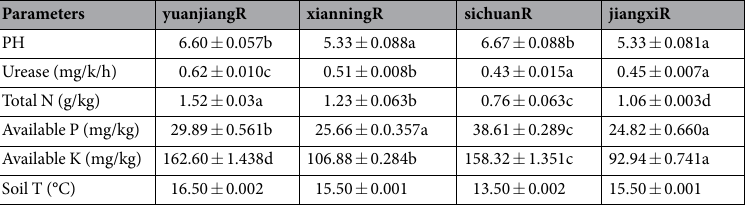
Table 1. The differences in soil chemical parameters in different areas of the continuous cropping ramie. Notes: the a, b, c and d indicate significant differences at p = 0.05.